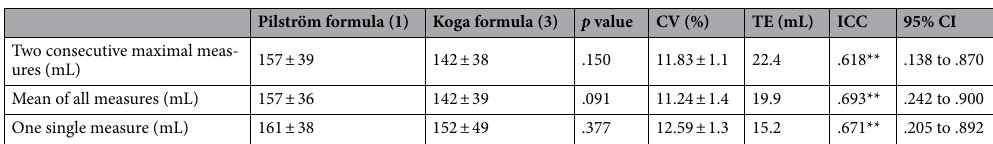
Table 2. Comparisons of different methods of establishing baseline splenic volume (Mean ± SD) between Pilström and Koga formulas with corresponding reliability measures. ** p < .01. Values refer to comparisons of test 1.